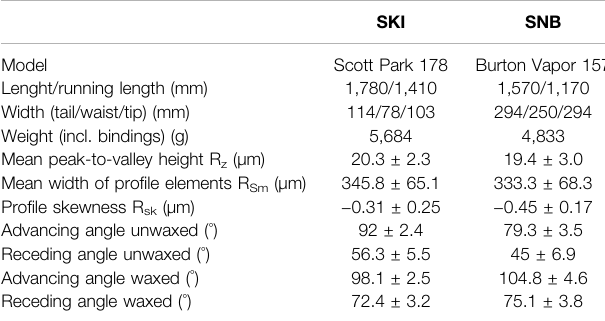
TABLE 1 | Properties of the test skis and snowboard including surface roughness parameters ( n (cid:1) 10) and dynamic contact angles of distilled water ( n (cid:1) 8).